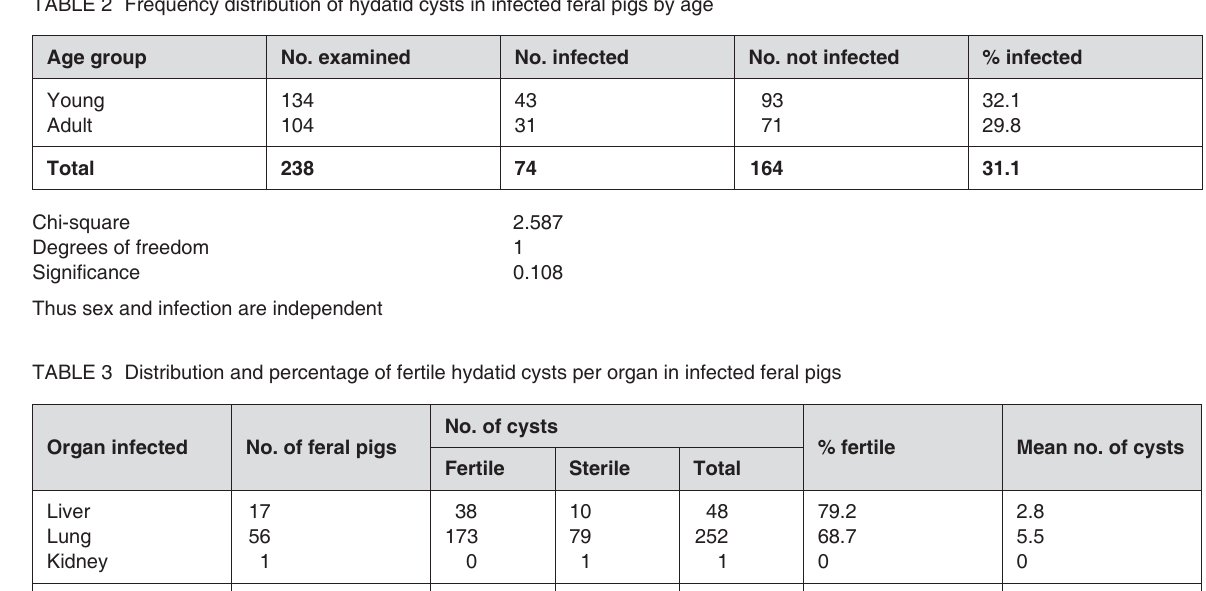
TABLE 2 Frequency distribution of hydatid cysts in infected feral pigs by age